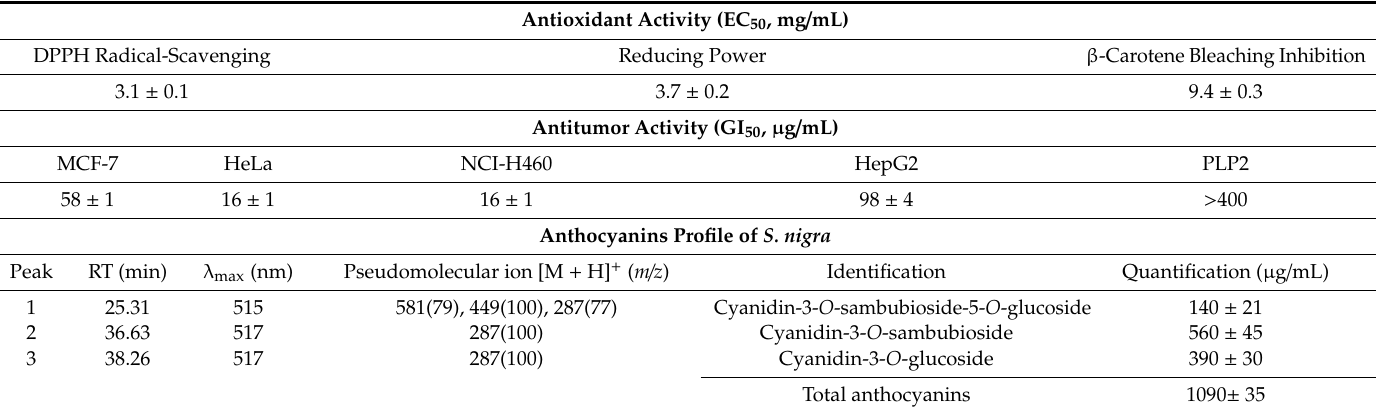
Table 1. Bioactivity and anthocyanin profile of Sambucus nigra